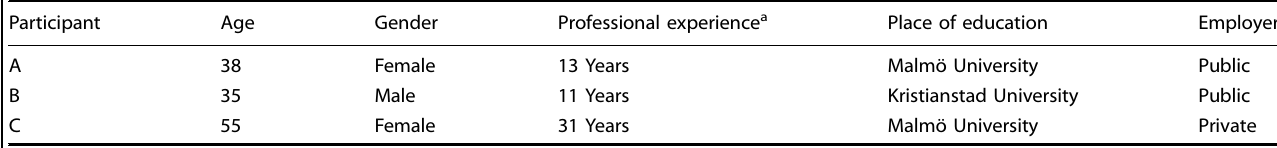
Table 1. Participants (dental hygienists)